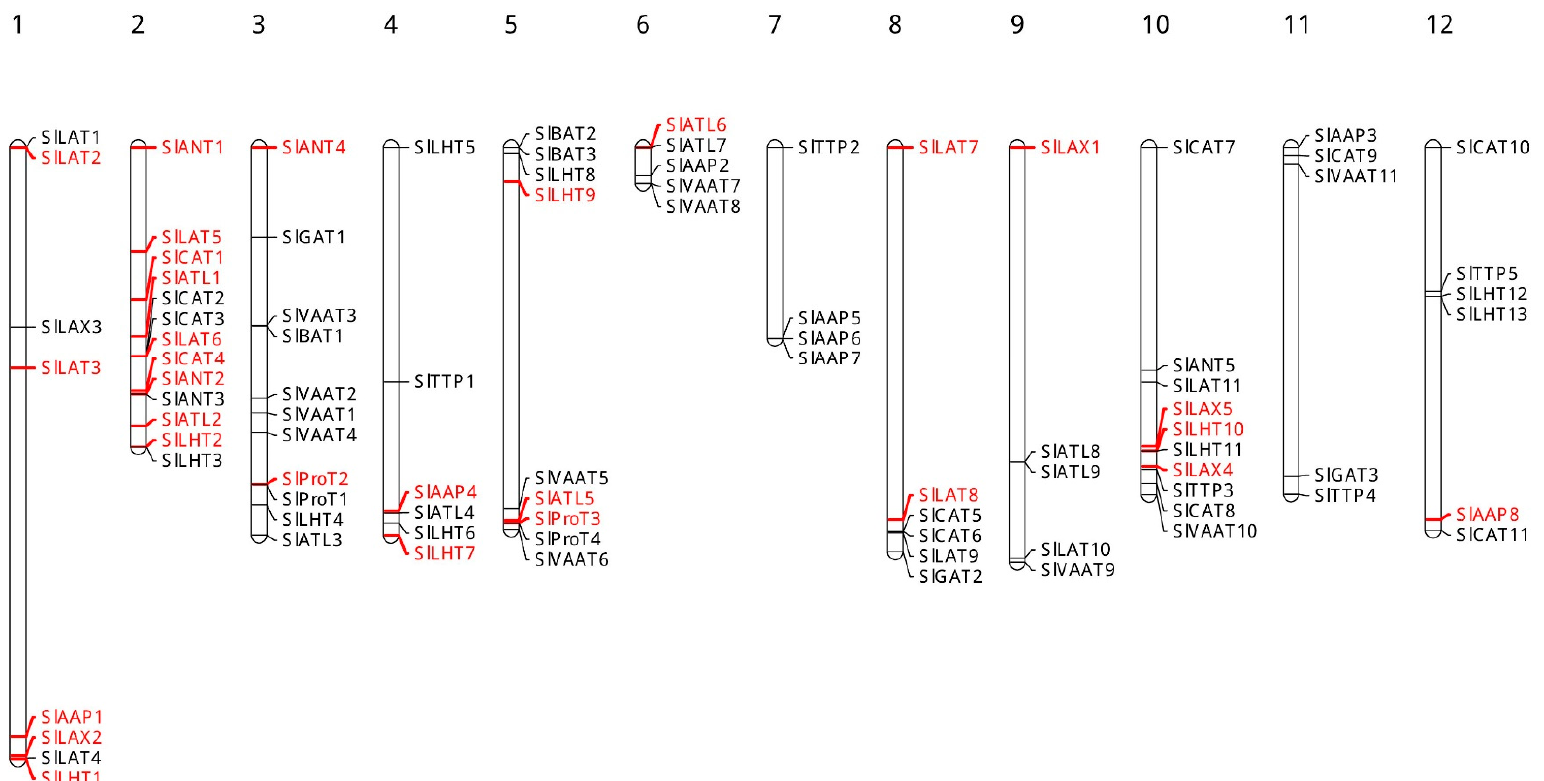
Figure 2. Chromosomal localization of SlAAT genes. Respective chromosome numbers are indicated at the top of each bar. Gene duplication events of SlAAT genes marked in red. (For interpretation of the references to color in this figure, the reader is referred to the web version of this article.) AAP, amino acid permease; ANT, aromatic and neutral amino acid transporter; ATL, amino acid transporter-like proteins; BAT, bidirectional amino acid transporter; CAT, cationic amino acid transporter; GAT, γ -aminobutyric acid transporter; LAT, L-type amino acid transporter; LAX, like-auxin influx carriers; LHT, lysine/histidine transporter; ProT, proline transporter; TTP, tyrosine-specific transporter; VAAT, vesicular aminergic-associated transporter.